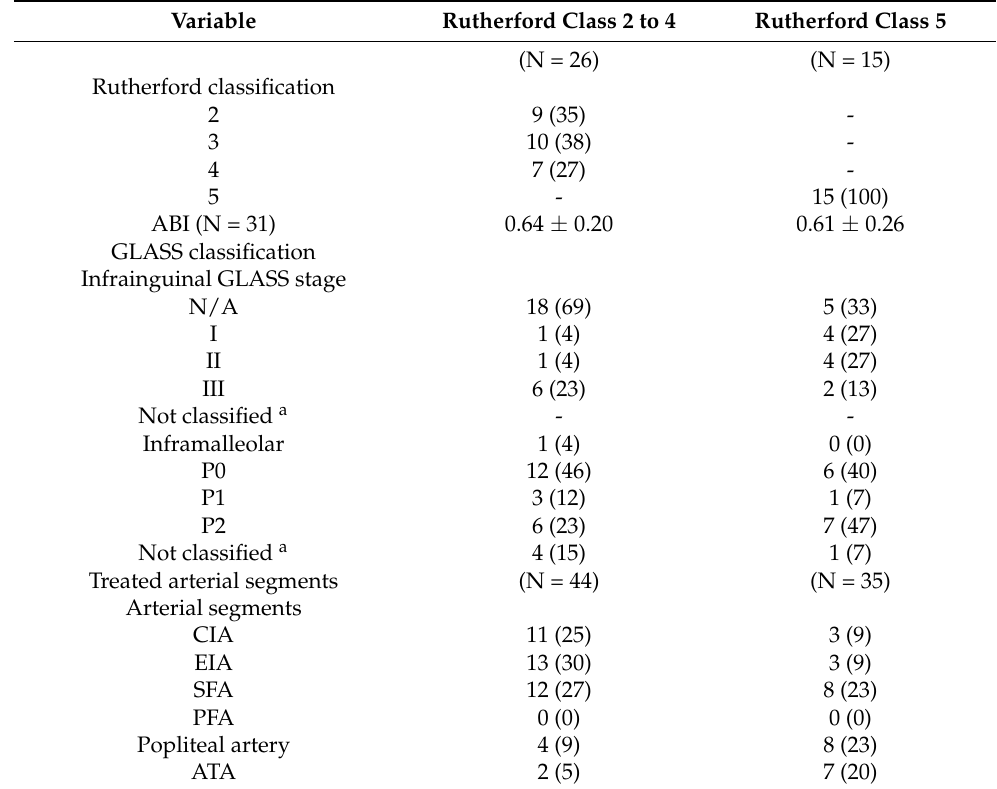
Table 2. Revascularization treatment characteristics of feet (n = 41) and arterial segments (n =